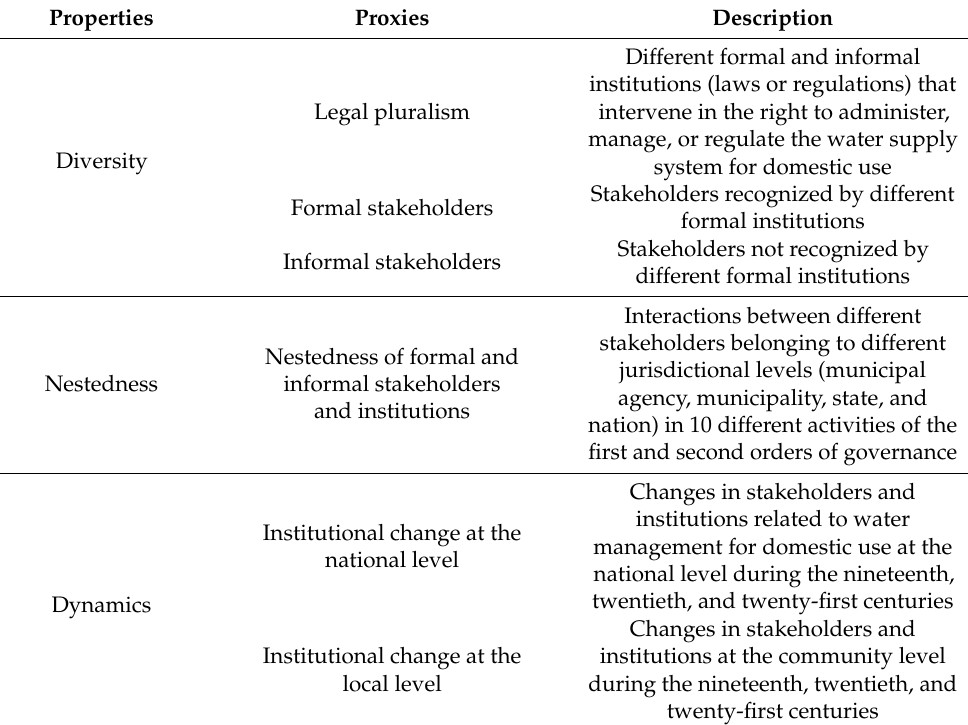
Table 1. Operationalization of the properties that comprise the complexity of the governance of the water supply system for domestic use through the diversity, nestedness, and dynamics of the Interactive Governance Framework (IGF). Sources: Prepared by the authors based on Bavinck and Kooiman